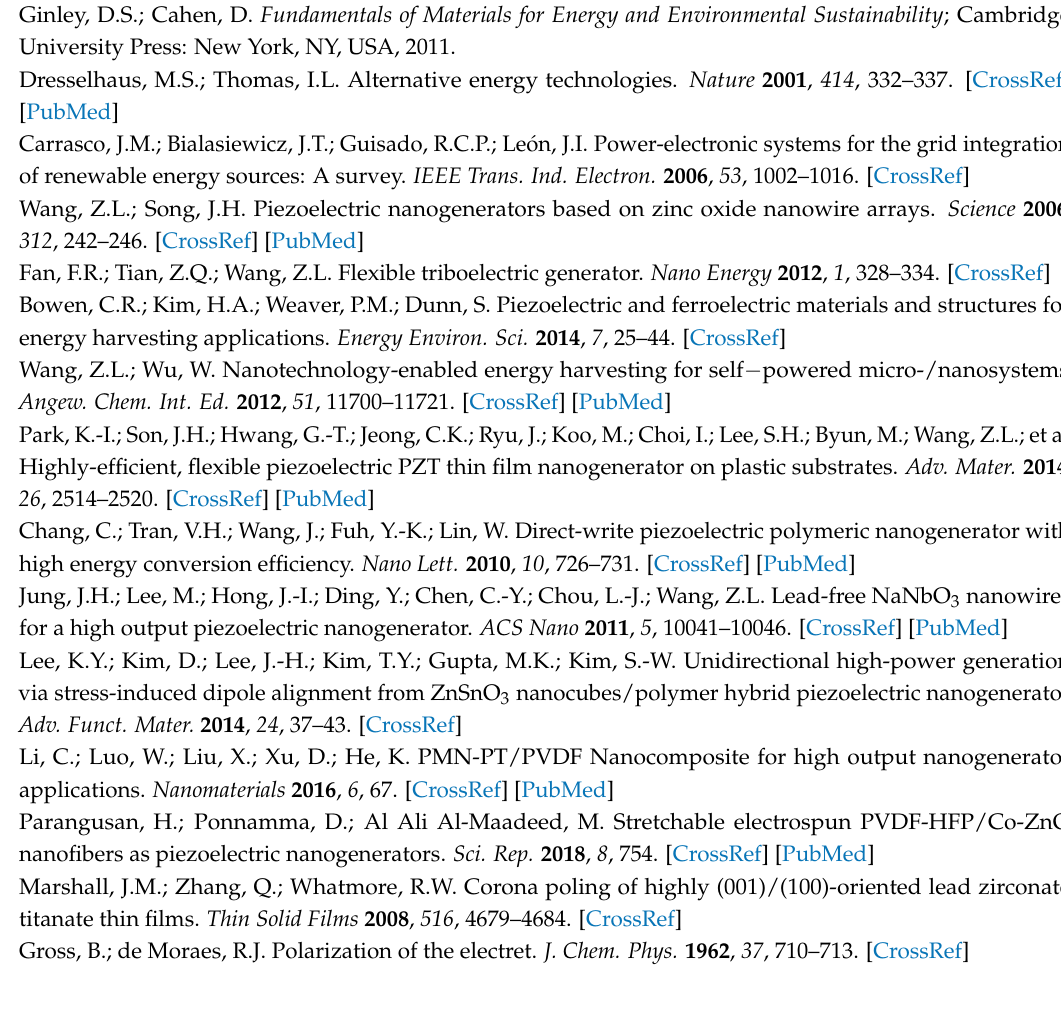
Supplementary Materials: The following are available online at http://www.mdpi.com/2079-4991/8/10/ 777/s1, Figure S1: energy-dispersive X-ray (EDX) spectra of the PVDF-BTO composite, Figure S2: detailed force-displacement curves at various BTO contents and Young’s modulus, Figure S3: schematic illustration of the strain calculation, Figure S4: bending speed and load-resistance dependent piezoelectric